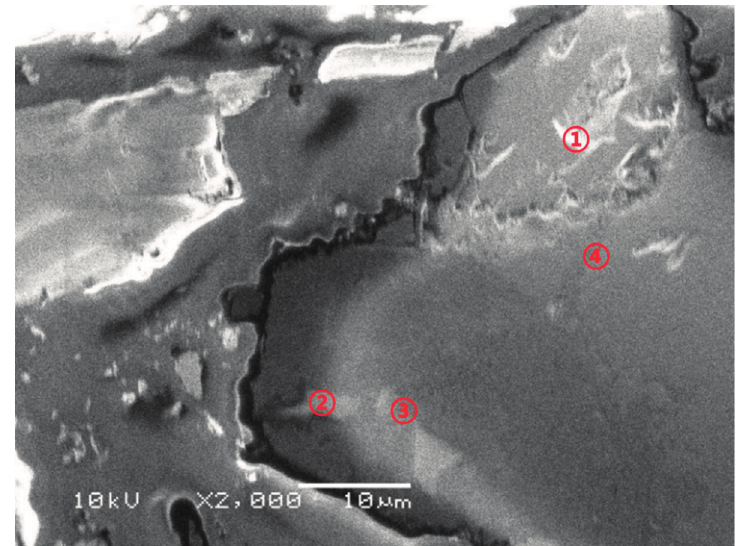
Figure 5. Scanning electron microscopic image of the raw monazite-bearing ore (3000× magnification). The detailed investigations are given in the text and Table 3.